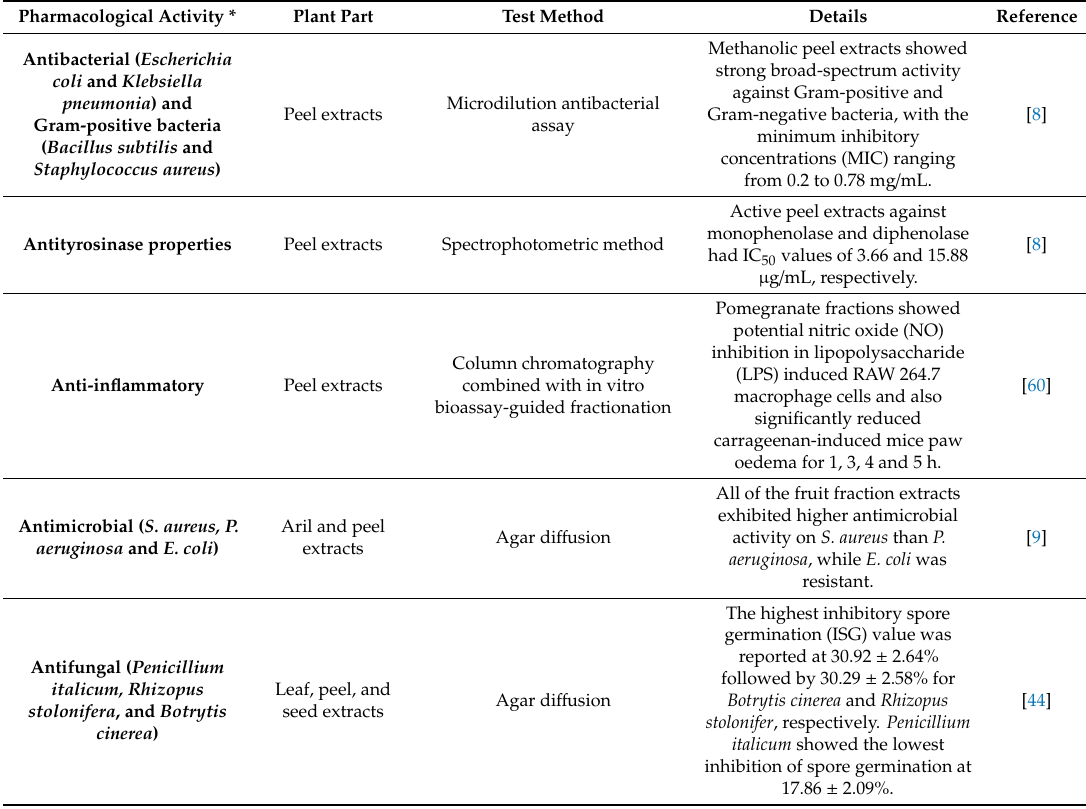
Table 2. Examples of published pharmacological studies on P . granatum